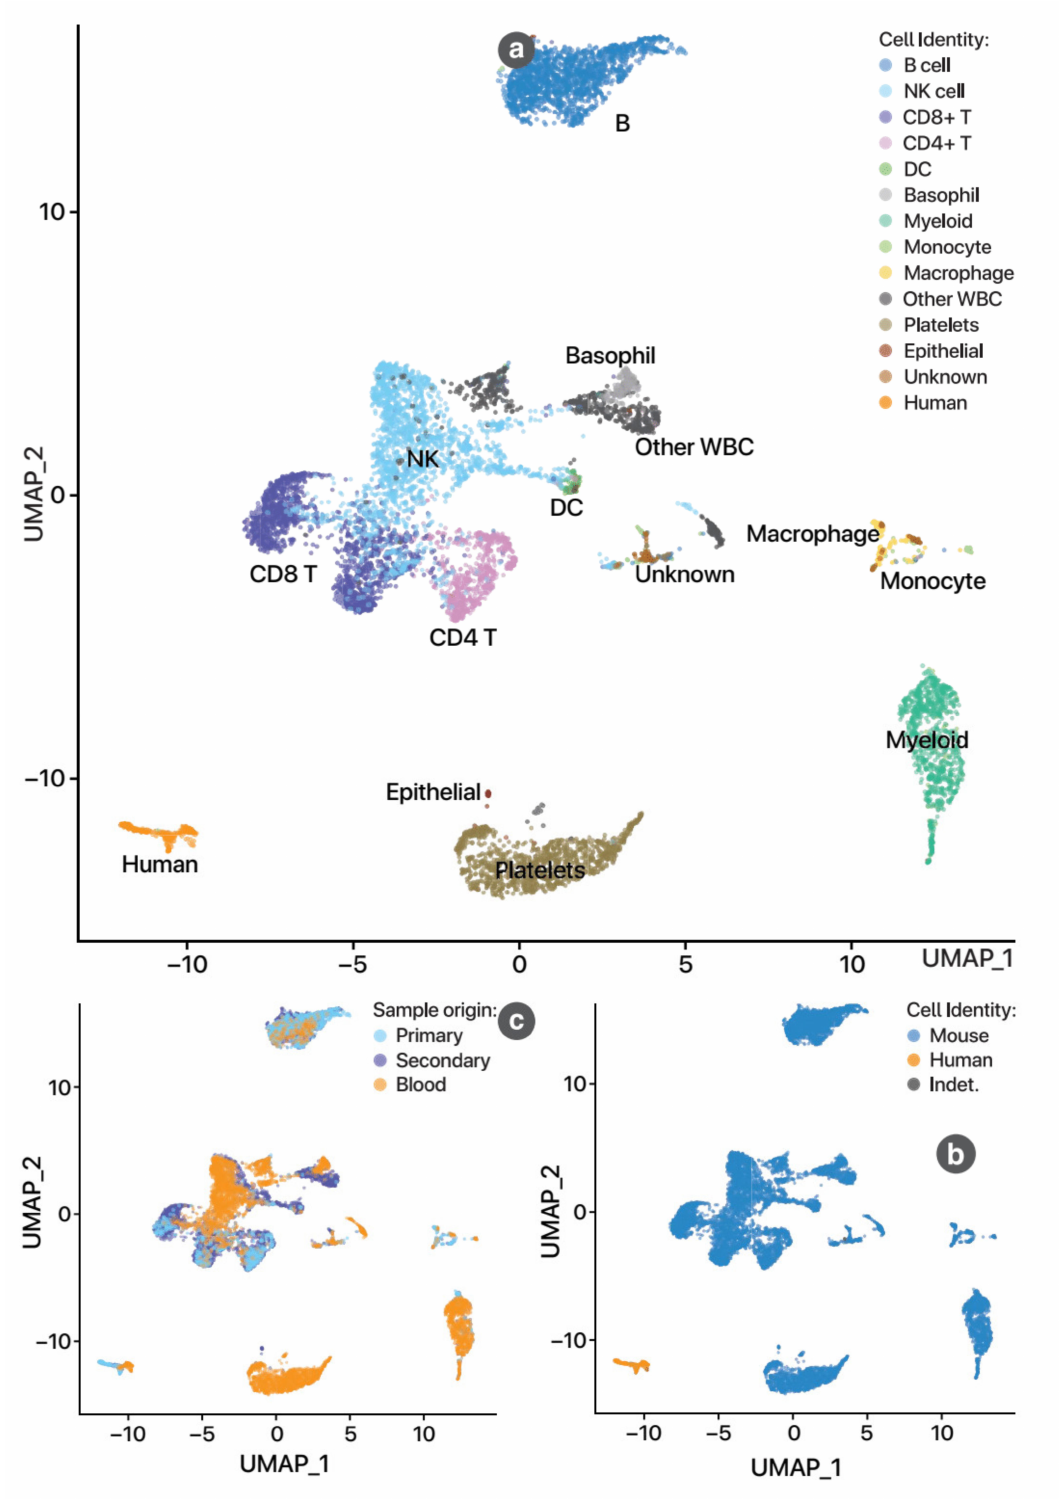
Figure A10. Successful integration of gene expression data across samples. These set of figures demonstrate cells clustered according to gene expression (i.e., cell type) ( a ), rather than to sample origin ( b ). Human cells clustered separate from mouse cells, as expected ( c ). Abbreviations: B, B lymphocyte. DC, dendritic cell. Indet., indeterminate. NK, natural killer cell. T, T lymphocyte. WBC, white blood